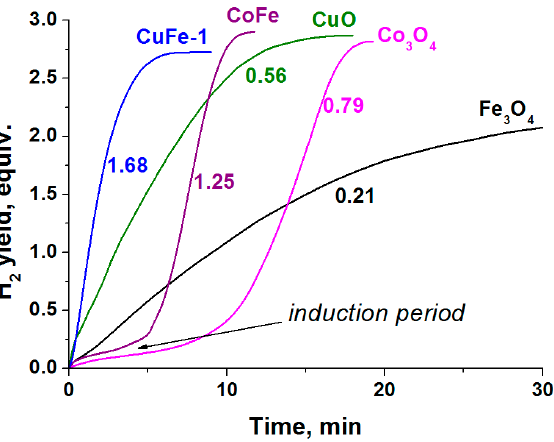
Figure 3. The influence of oxides on the hydrogen generation during catalytic hydrolysis of NH 3 BH 3 (0.123 M) at 60 ° C. The numbers indicate the attainable rate of H 2 generation expressed as NH 3 BH 3 (0.123 M) at 60 ◦ C. The numbers indicate the attainable rate of H 2 generation expressed as ⋅ min − 1 ⋅ g − 1cat . L H L H2 · min − 1 · g − 1 cat . 2